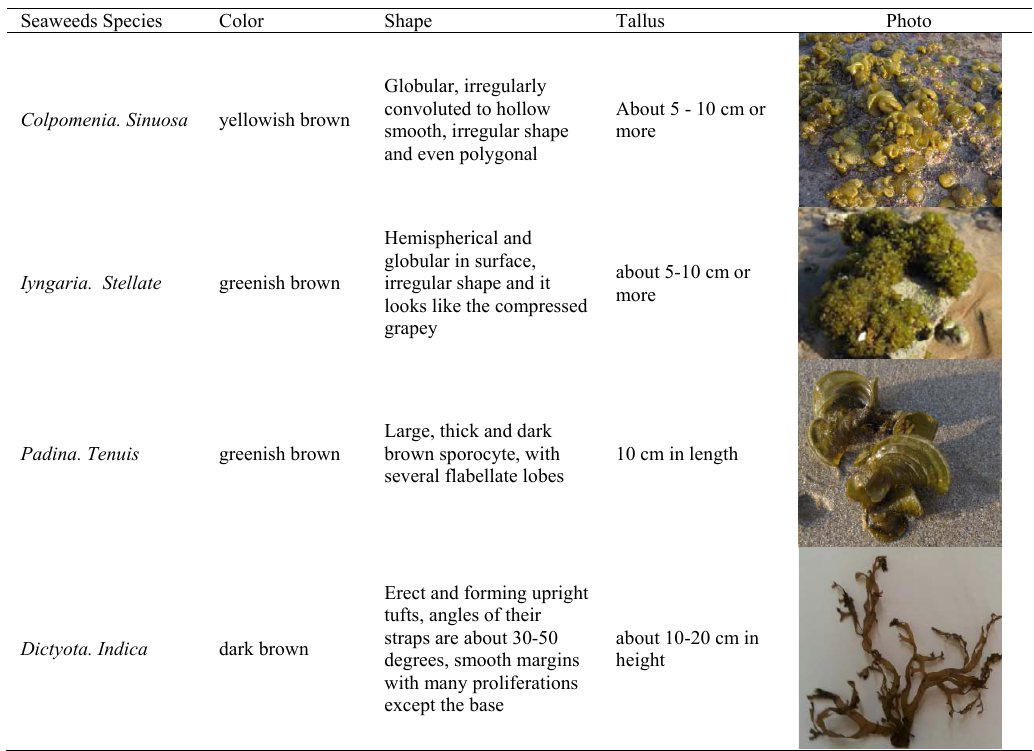
Table 1: Characterization of the studied samples